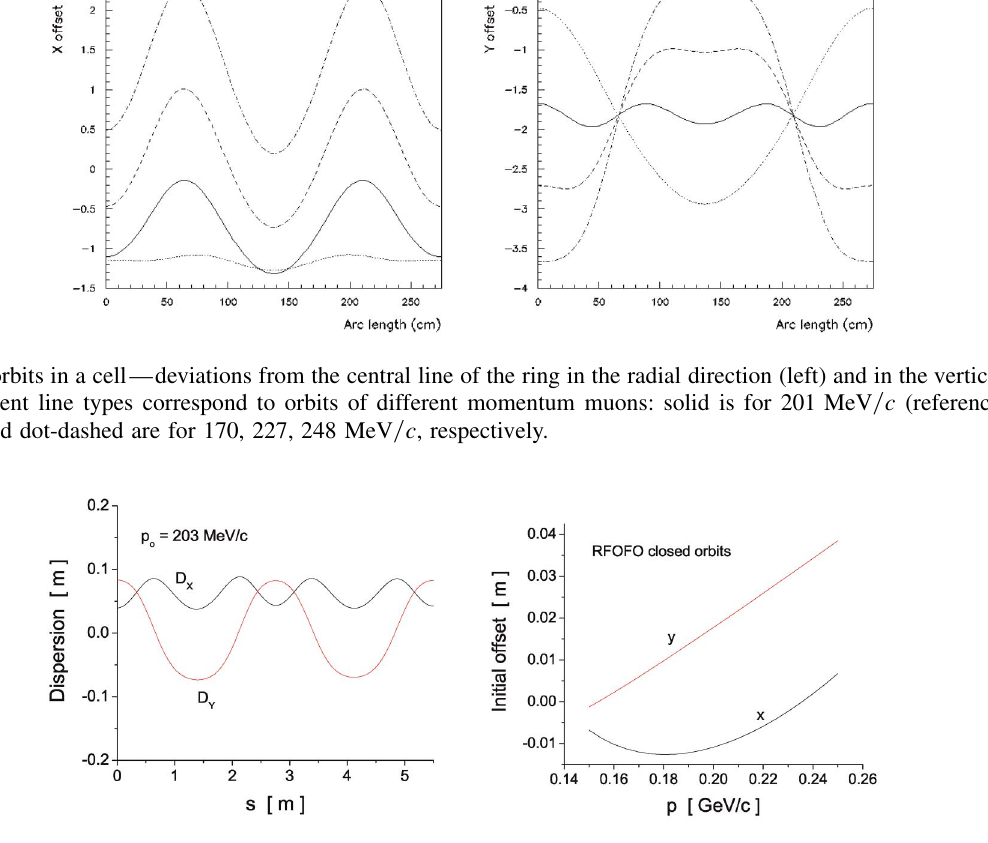
FIG. 9. (Color) (left) Dispersion vs position in the cell; (right) initial offset vs muon momentum.